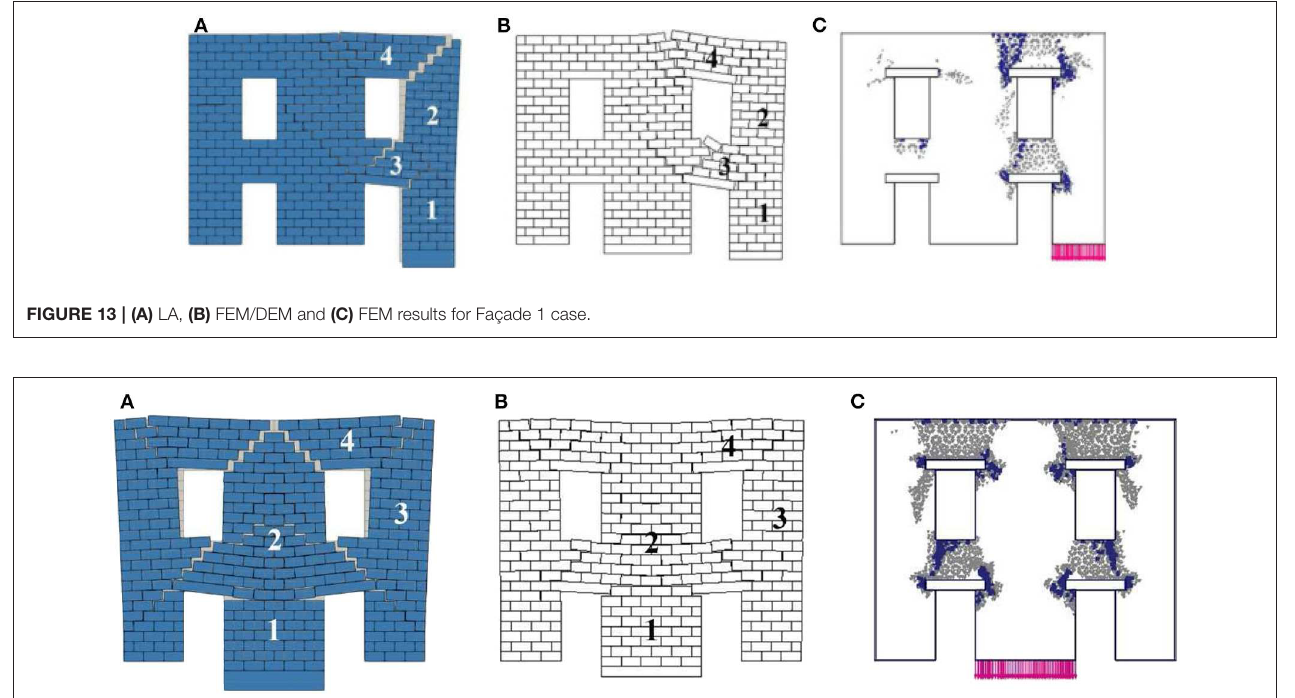
FIGURE 14 | (A) LA, (B) FEM/DEM, and (C) FEM results for Façade 2